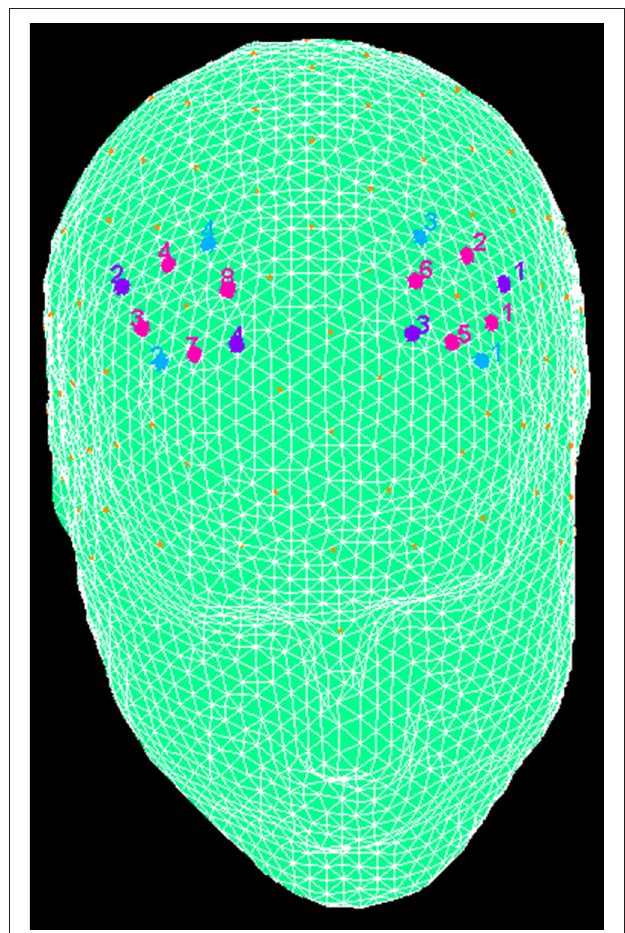
FIGURE 2 | The location of near-infrared spectroscopy (NIRS) channels. The emitters were placed on positions FC3-FC4 (purple, number 1 and 2) and F1-F2 (number 3 and 4), while detectors were placed on FC1-FC2 (blue, number 3 and 4) and F3-F4 (number 1 and 2). Resulting channels are displayed in pink